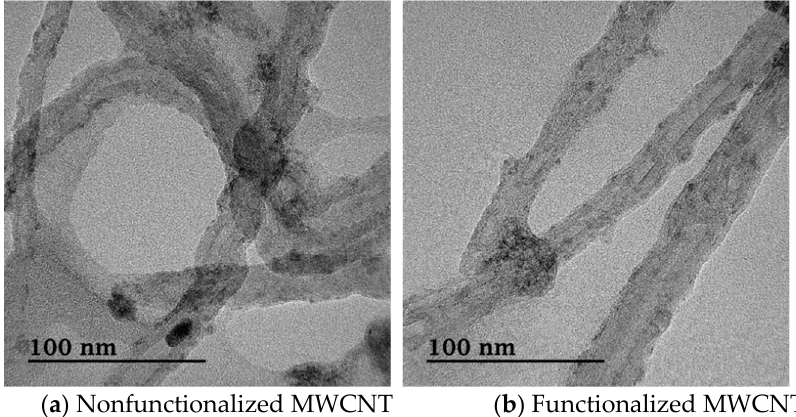
Figure 2. Transmission electron microscope (TEM) image of ( a ) nonfunctionalized and ( b ) functionalized multiwalled carbon nanotube (MWCNT) nanofluid with aspect ratio of 100 nm.